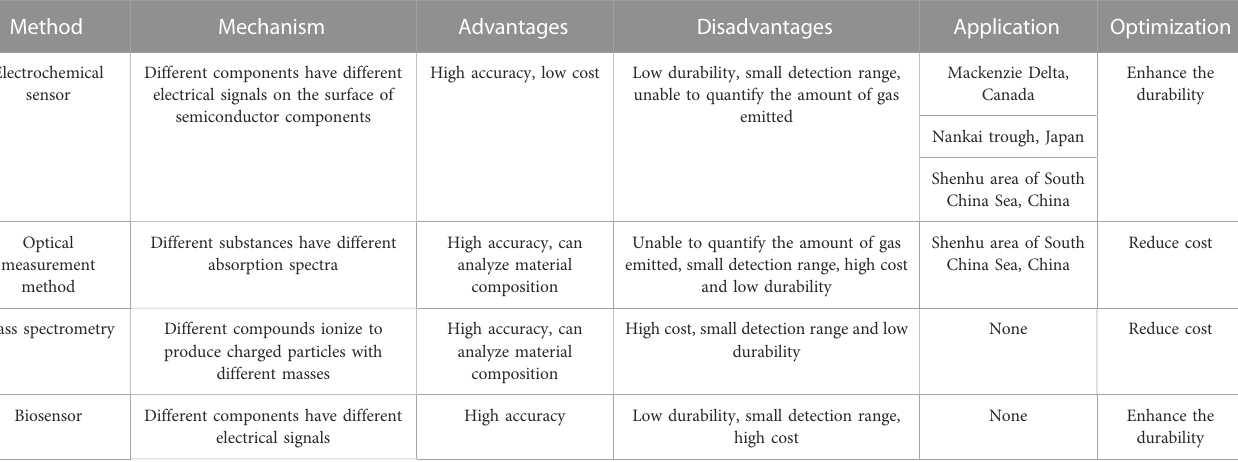
TABLE 3 Detection methods for